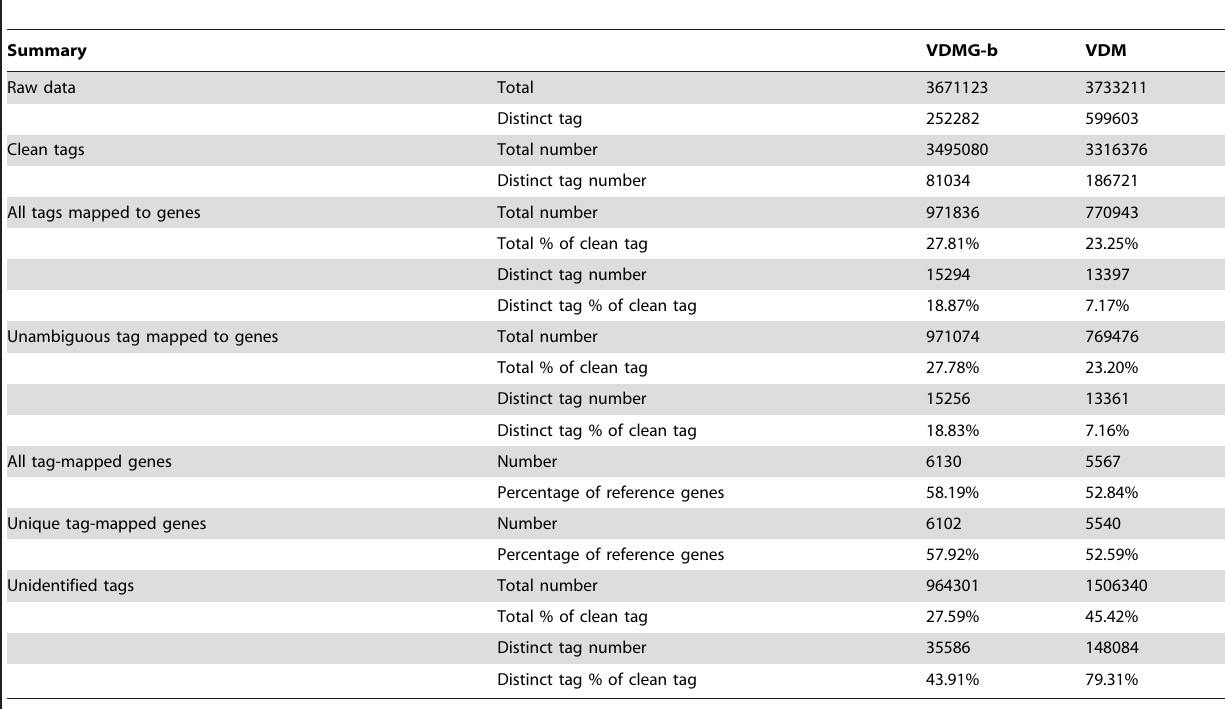
Table 3. Number of sequenced expression tags during the germination of Verticillium dahliae microsclerotia in the germinated (VDMG-b) and non-germinated (VDM) microsclerotia.